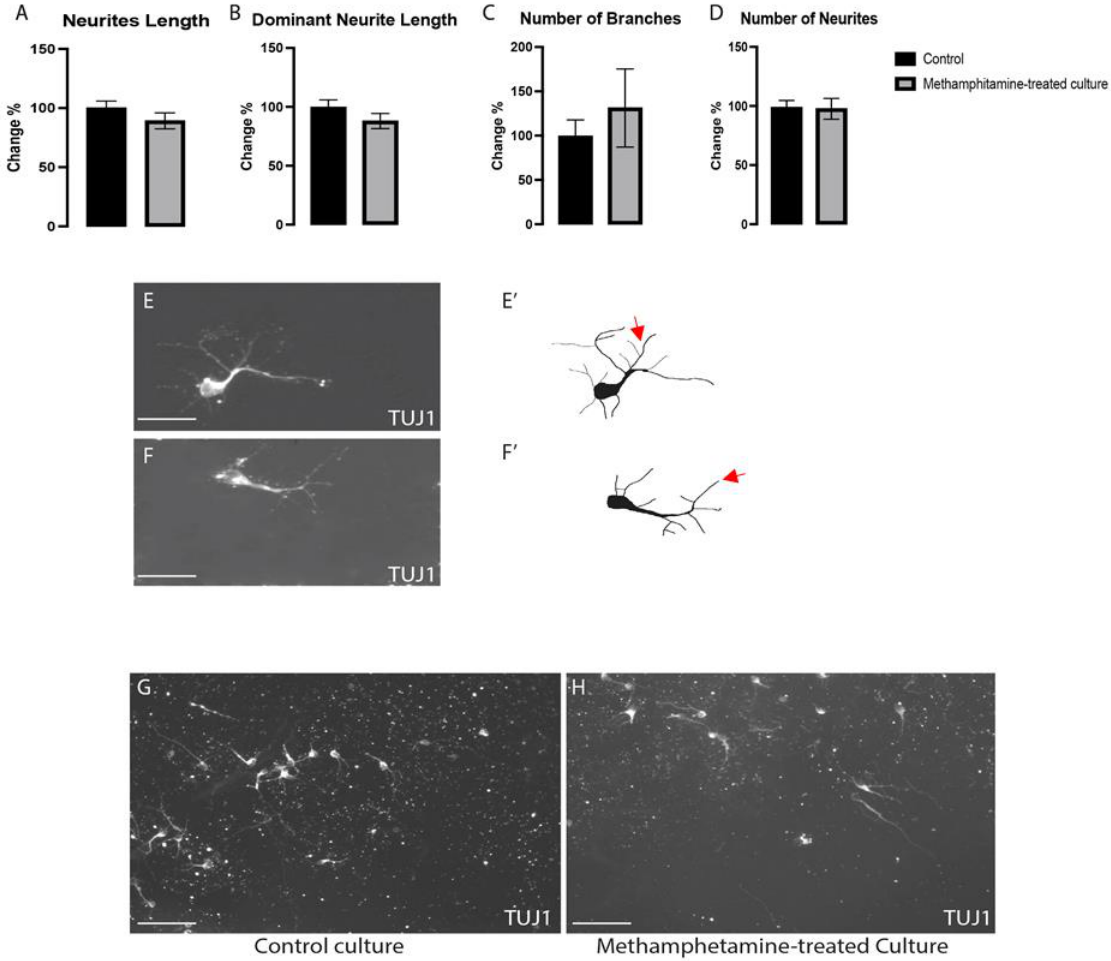
Figure 4. The morphogenesis of non-dopaminergic VMNs was not significantly changed upon exposure to methamphetamine ( A – D ). There were no discernible differences between the control ( E , E’ ) and meth-treated ( F , F’ ) groups in representative photos and illustrations for non-dopaminergic VMNs immunolabeled with class III beta-tubulin (TUJ1). ( G , H ) Images show a large field of view (20×) for both groups: control and methamphetamine-treated cultures, respectively; n = three technical replicates and four biological replicates. Data are shown as the mean ± SEM. Data were analyzed using a t -test. Scale bar= 50 µm ( E , F ). Scale bar= 10 µm ( G , H ). Red arrows show examples of branches.